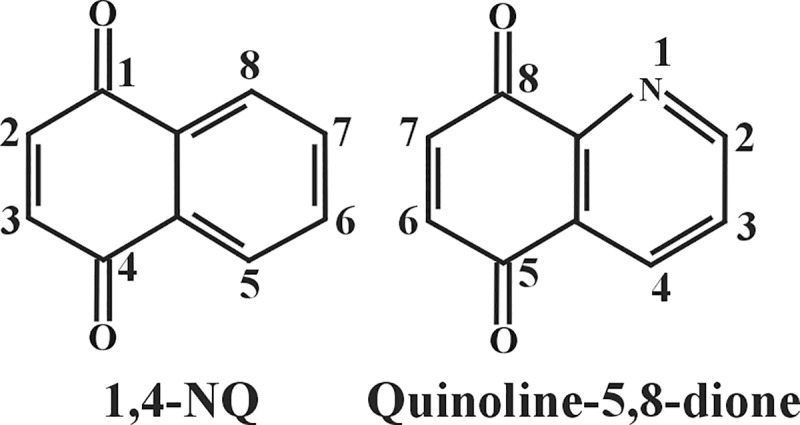
Structure of 1,4-NQ and quinoline-5,8-dione.